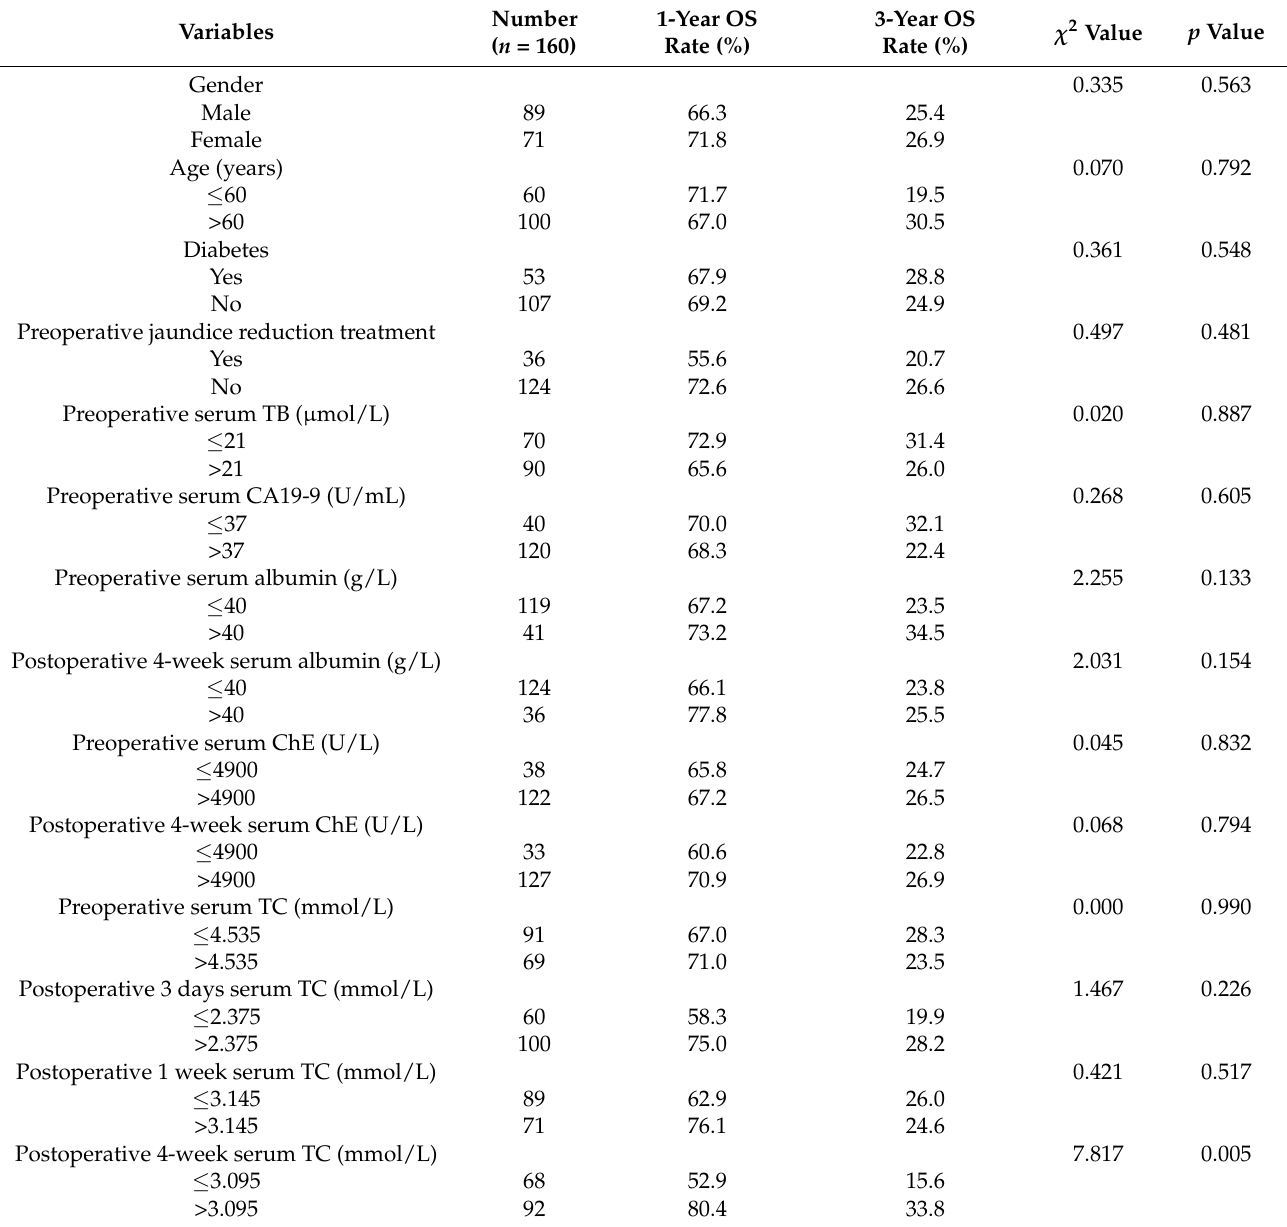
Table 7. Univariate analysis of postoperative long-term survival in pancreatic cancer